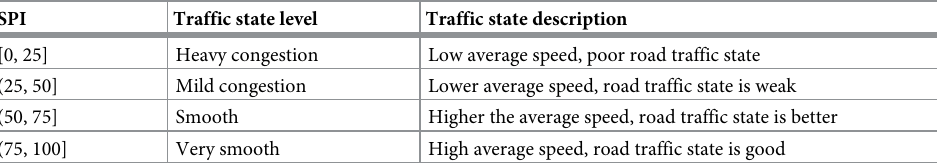
Table 1. Speed performance index with traffic